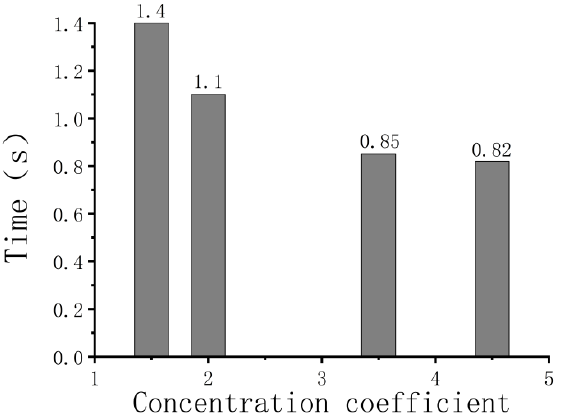
Figure 14. Engine cold-start time under different enrichment coefficients.